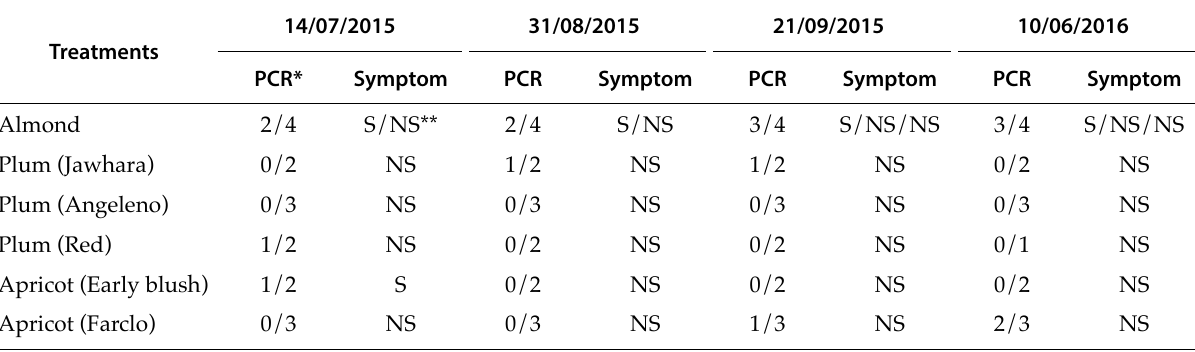
Table 2. Greenhouse experiment: symptom development and PCR detection of ‘ Ca . P. phoenicium’ in the almond scions grown from grafted